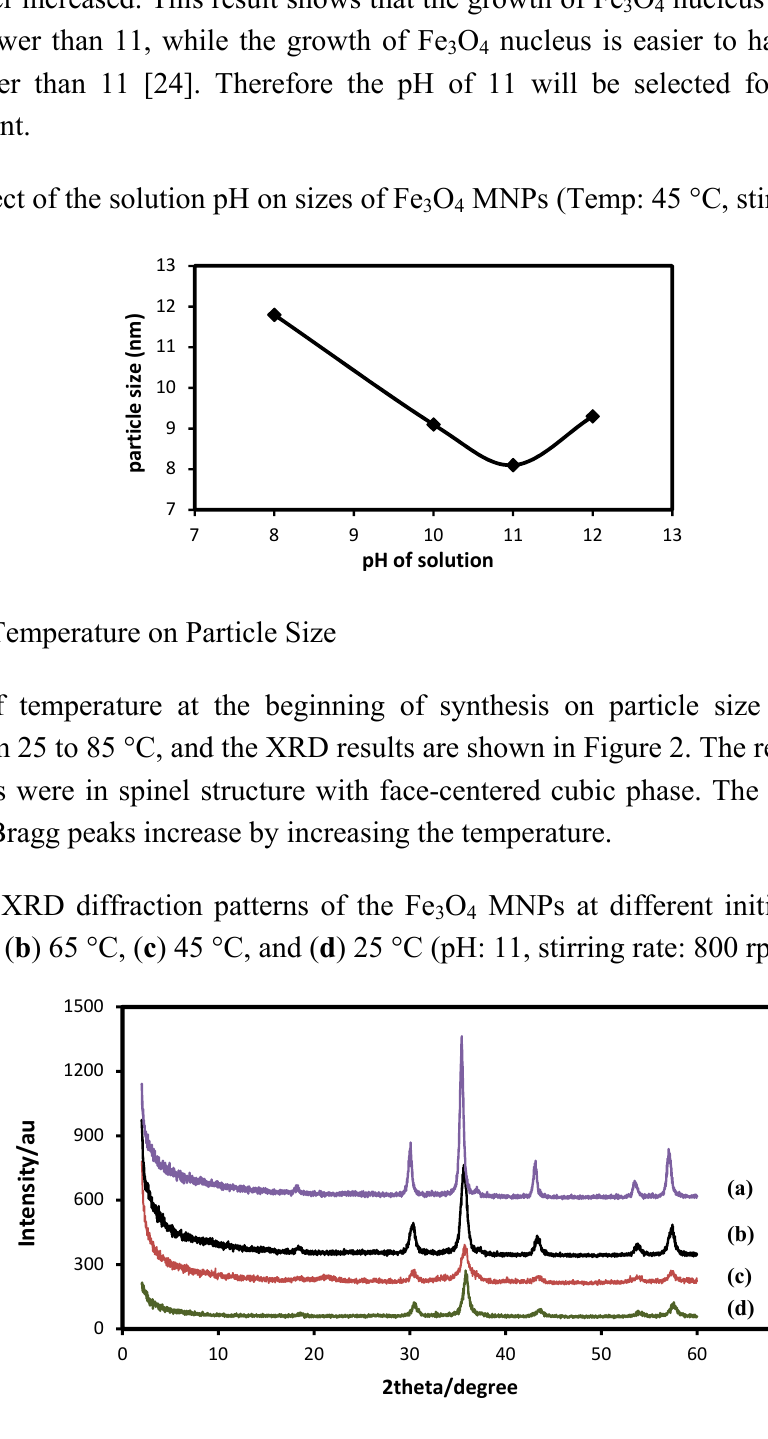
Figure 1. Effect of the solution pH on sizes of Fe